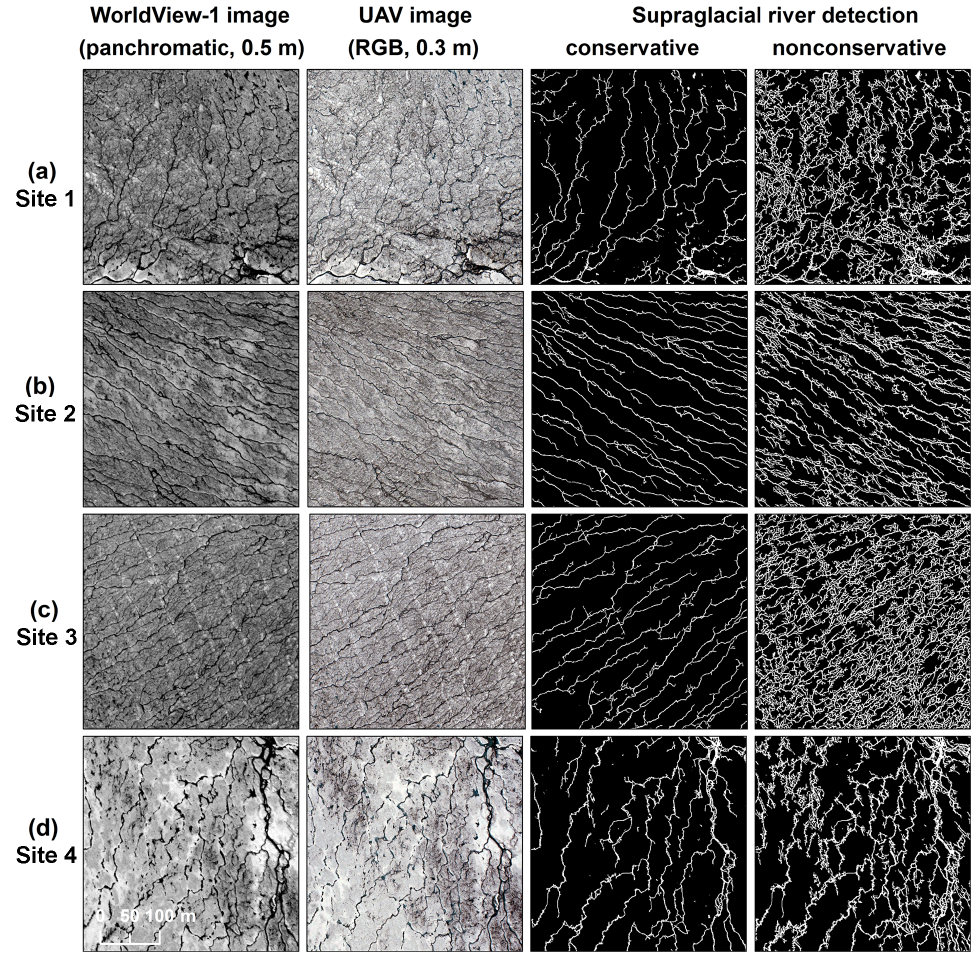
Figure 3. An 18 July 2015 panchromatic WorldView-1 (WV1) image (spatial resolution 0.5m, column 1), concurrent UAV imagery (spatial resolution 0.3m, column 2), and corresponding supraglacial rivers and streams delineated from the WV1 imagery for Sites 1–4. Column 3 shows conservative detection of actively flowing channels, while column 4 shows nonconservative